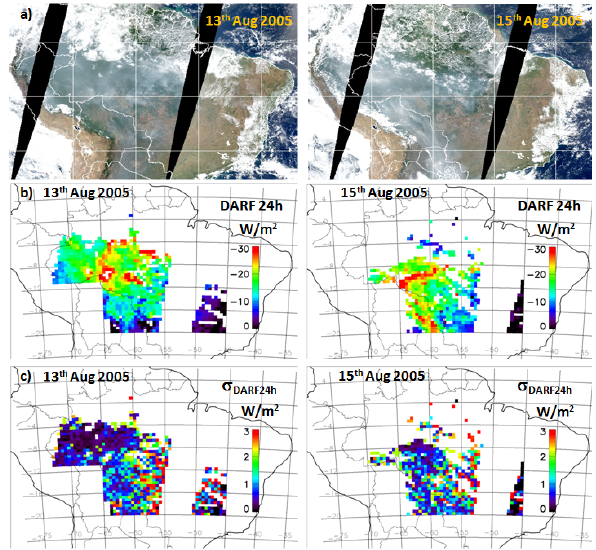
Figure 2. (a) Examples of composite MODIS RGB (red, green, blue) images over the Amazonia, (b) mean daily spatial distribu- tions of the direct aerosol radiative forcing of aerosols (24h-DARF), (c) and their uncertainties for 13 August 2005 (left) and 15 Au- gust 2005